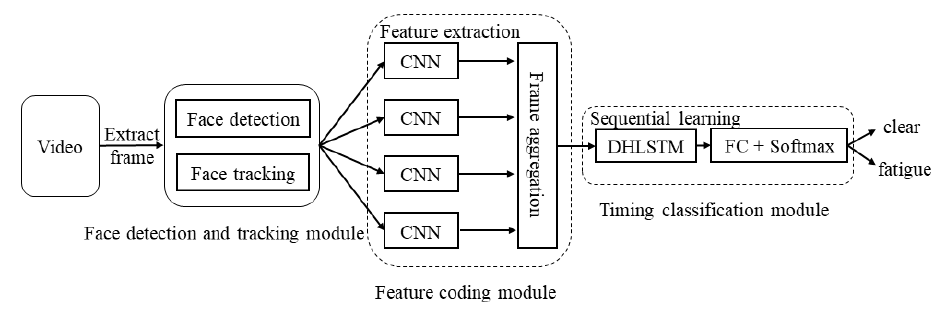
Figure 1. Overall flowchart of the method.